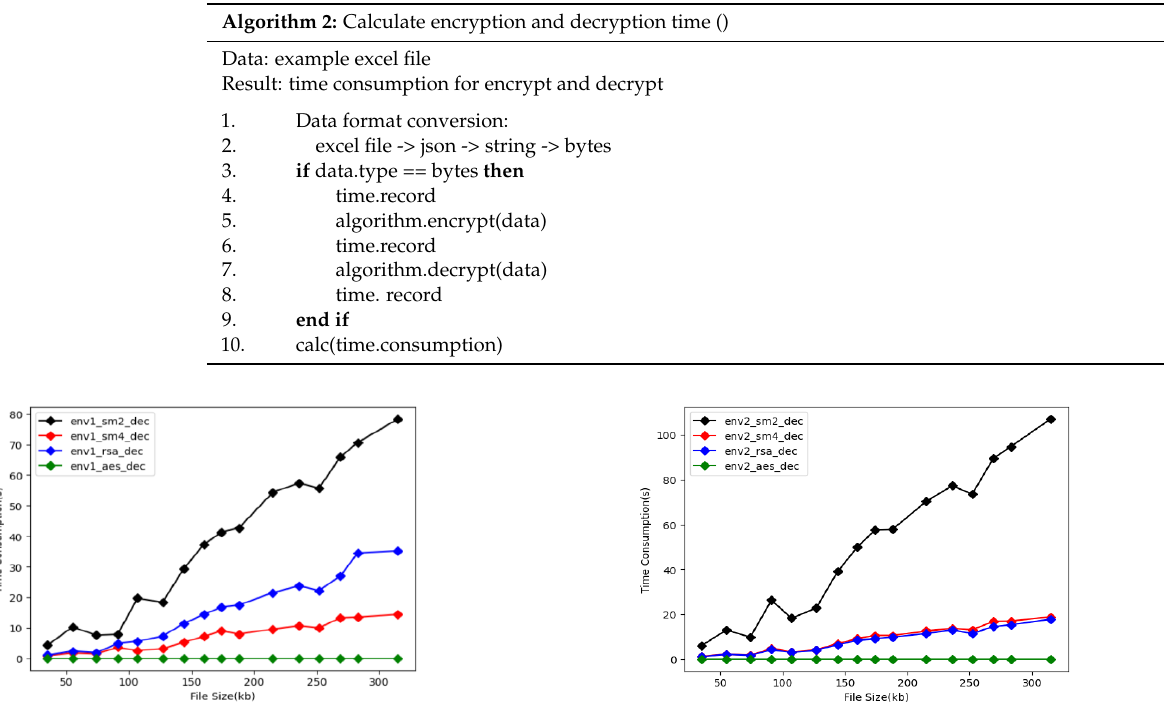
Figure 12. Time consumption of authorized decryption of different experimental samples using SM2, SM4, AES, and RSA in env-1 and env-2. Algorithm 2: Calculate encryption and decryption time ()